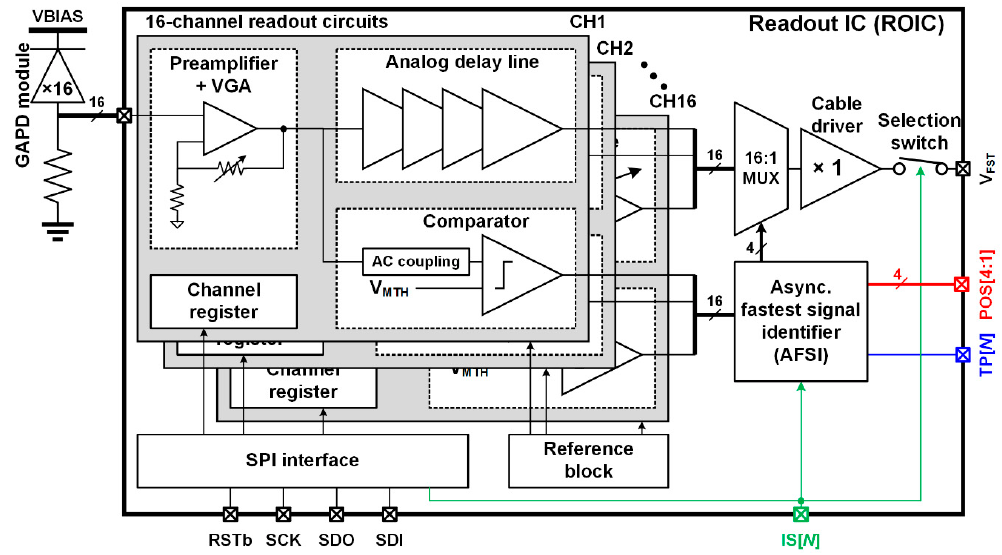
Figure 1. ( a ) Block diagram of a positron emission tomography (PET) system based on the proposed readout integrated circuit (ROIC) and ( b ) timing diagram of the analog signal processing (ASP) block.